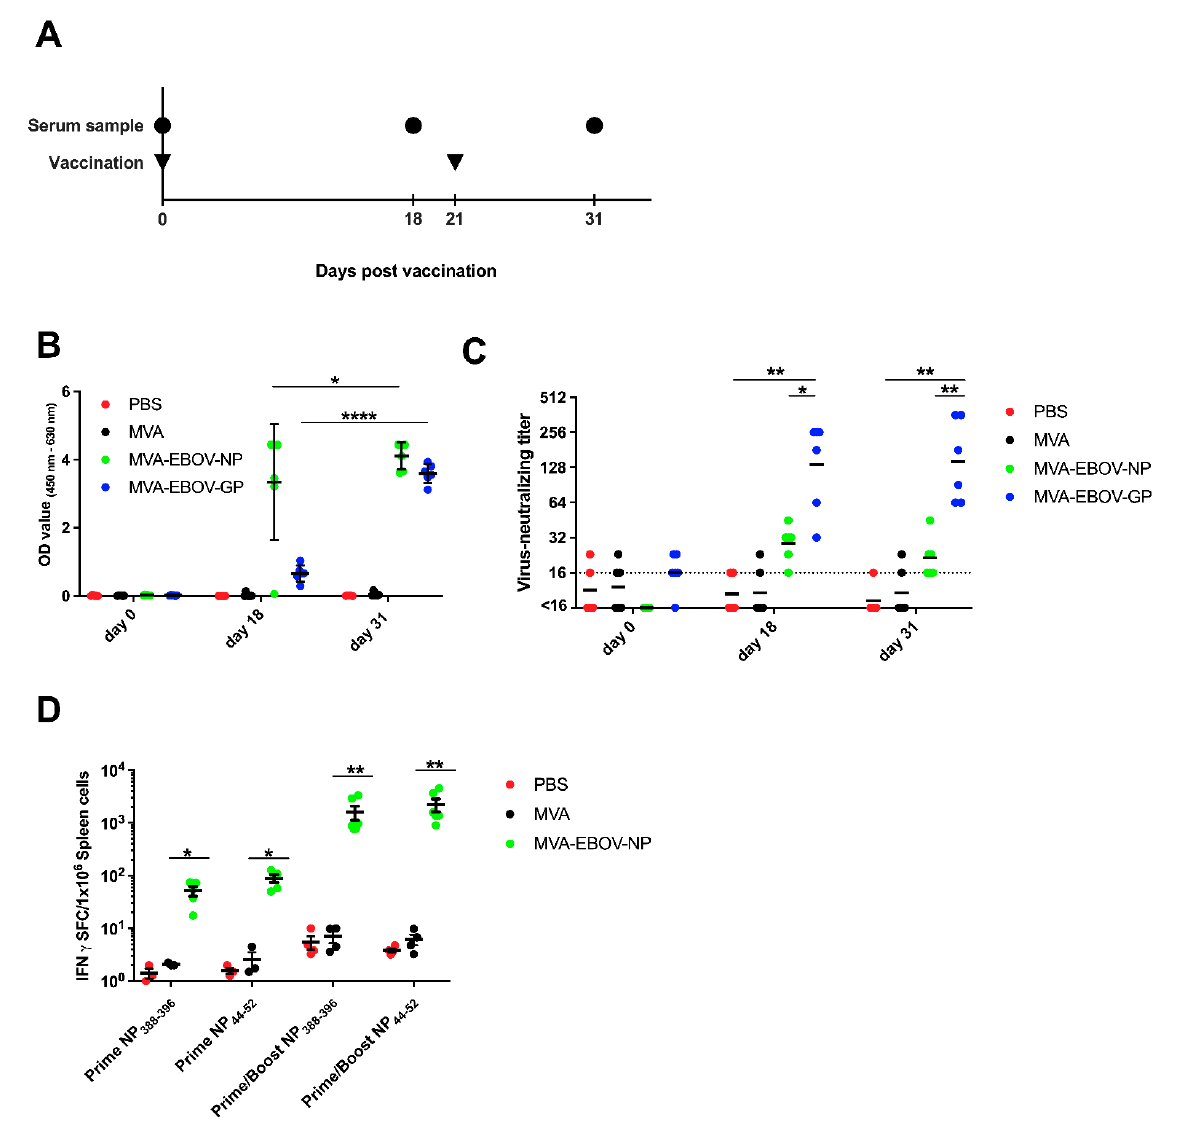
Figure 2. Immunogenicity of recombinant MVA-EBOV vaccines. ( A ) IFNAR -/- mice were vaccinated intramuscularly with either PBS or 10 8 PFU non-recombinant MVA (MVA) as controls or with 10 8 PFU of the recombinant viruses MVA-EBOV-NP and MVA-EBOV-GP in a prime-boost regimen. Serum samples were taken at the indicated time points. ( B ) EBOV-virion ELISA performed with serum samples obtained at days 0, 18 and 31 after the prime vaccination of mock-vaccinated and vaccinated mice. Mean optical density values were measured at 450–620 nm; error bars: standard deviation; PBS: n = 5 mice, MVA, MVA-EBOV-GP, MVA-EBOV-NP: n = 6 mice. ( C ) Geometric mean EBOV-neutralizing titer determined by virus neutralization assay on days 0, 18 and 31 after prime vaccination, respectively; dotted line: limit of detection; PBS: n = 5 mice, MVA, MVA-EBOV-GP, MVA-EBOV-NP: n = 6 mice. ( D ) EBOV NP-specific CD8+ T cell response was measured by ELISPOT assay. Splenocytes were prepared at eight days after prime or prime/boost vaccination. NP 388–396 or NP 44–52 epitope-specific, IFN-spot forming CD8+ T cells (IFN-SFC) were quantified; bar: mean, error bars: standard error of the mean; PBS, MVA-prime NP: n = 3 mice; PBS, MVA-prime/boost NP: n = 4 mice; MVA-EBOV-NP-prime NP: n = 5 mice; MVA-EBOV-NP-prime/boost: n = 6 mice. * p < 0.05; ** p < 0.01, **** p <